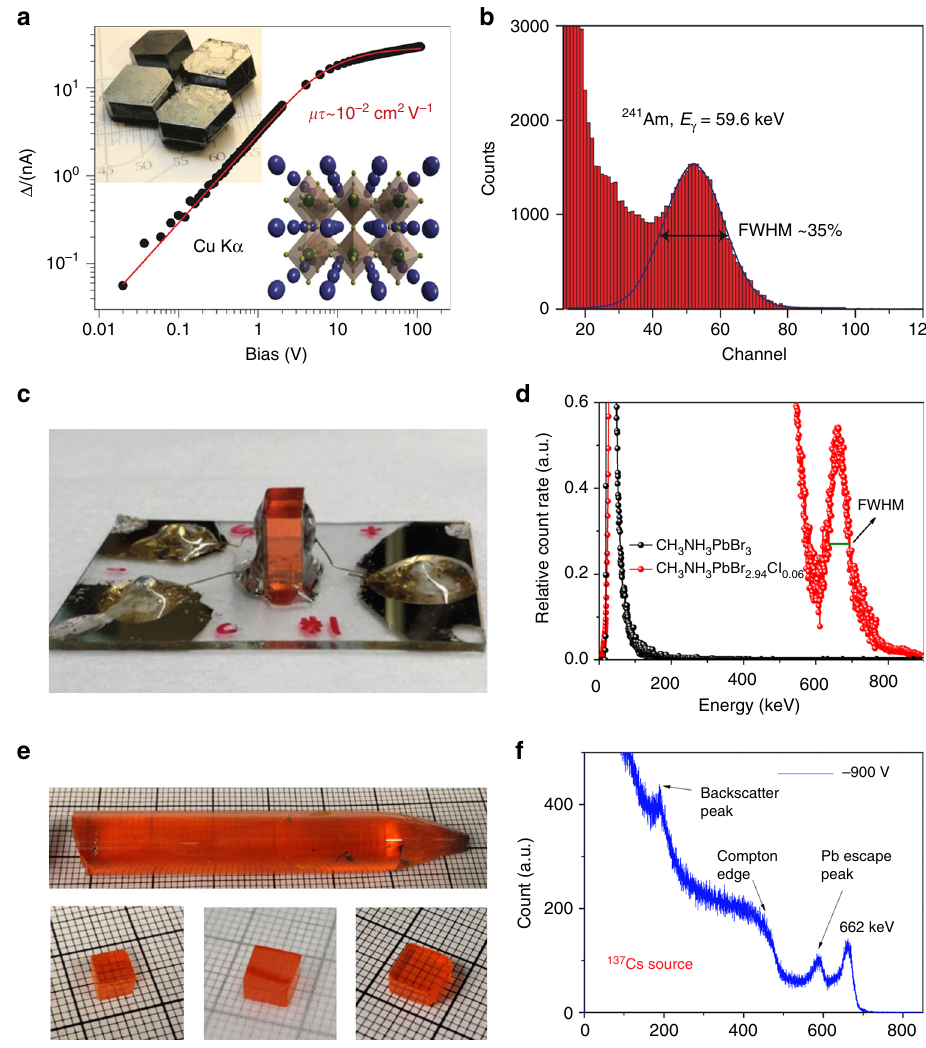
Fig. 4 γ -Ray spectrum detection by halide perovskites. a The bias dependence of the photocurrent generated by Cu K α X-ray in a MAPbI 3 single crystal (SC); the red line indicates a fi t with the Hecht model. Top inset: Photograph of typical MAPbI 3 perovskite SCs grown from a non-aqueous method. Bottom inset: Schematic of the three-dimensional interconnection of PbI 6 octahedra in a perovskite lattice (green, Pb; yellow, I; blue, MA). b Energy-resolved spectrum of 241 Am recorded with a FAPbI 3 SC. c Side view of a CH 3 NH 3 PbBr 2.94 Cl 0.06 SC detector, and electrode sides were encapsulated with epoxy. d Enlarged photopeak region of the 137 Cs energy spectrum obtained by CH 3 NH 3 PbBr 2.94 Cl 0.06 and CH 3 NH 3 PbBr 3 SC detectors. e As-grown CsPbBr 3 SC ingot with a diameter of 11 mm, and the SC wafers with different sizes. f Energy-resolved spectrum of 137 Cs γ -ray source with the characteristic energy of 662 keV obtained by a CsPbBr 3 detector. a , b (ref. 72 ), c , d (ref. 46 ), and e , f (ref. 48 ) are all adapted with permission from Springer